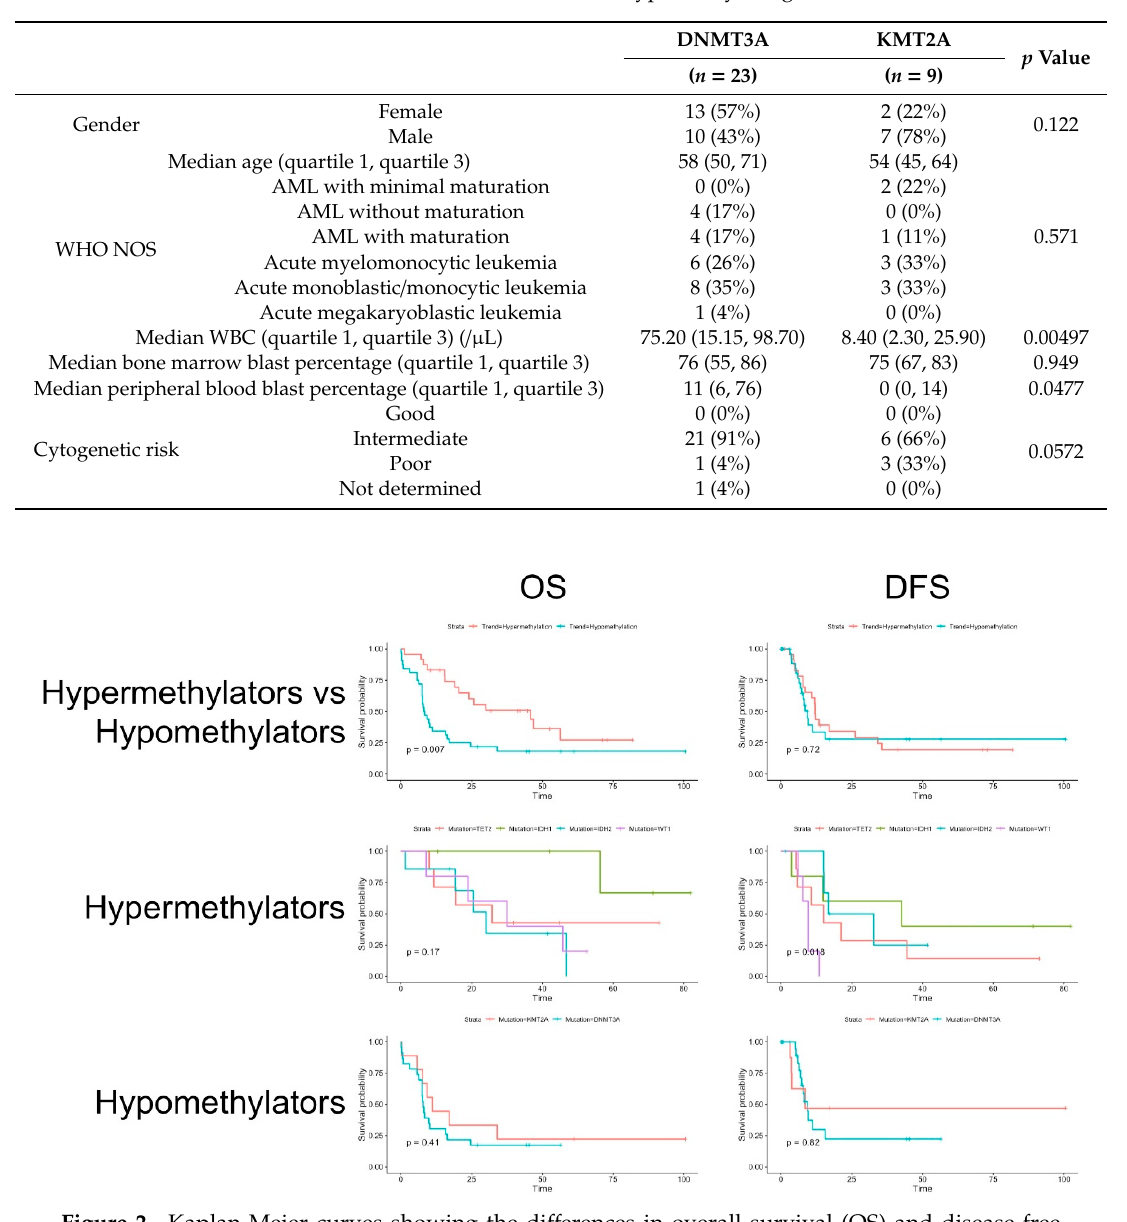
Figure 2. Kaplan-Meier curves showing the differences in overall survival (OS) and disease-free survival (DFS) between the hypermethylating and hypomethylating groups and in subgroup analysis between mutations.